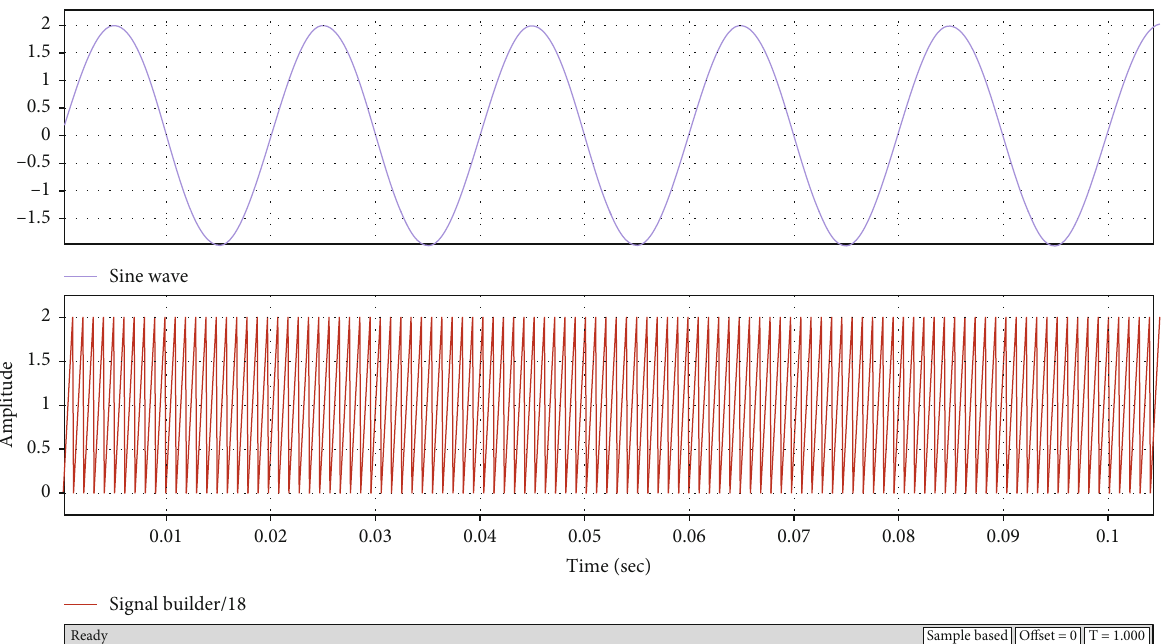
Figure 21: Sine wave and Saw tooth wave generated for calculating K